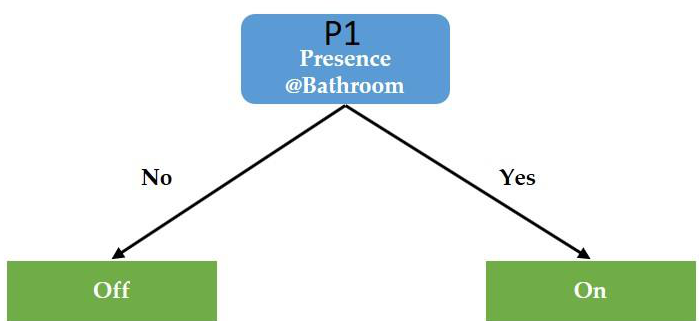
Figure 11. Decision tree for Bathroom Odor extractor over Period 1.